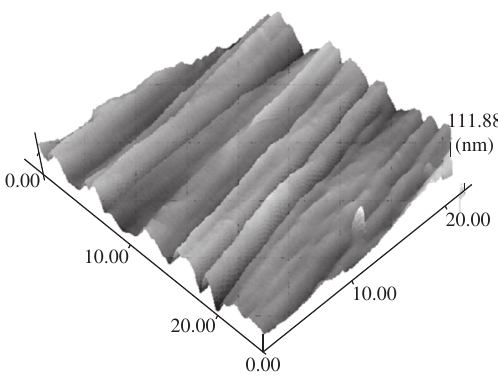
Figure 7. AFM image of ternary SiO 1 hour.